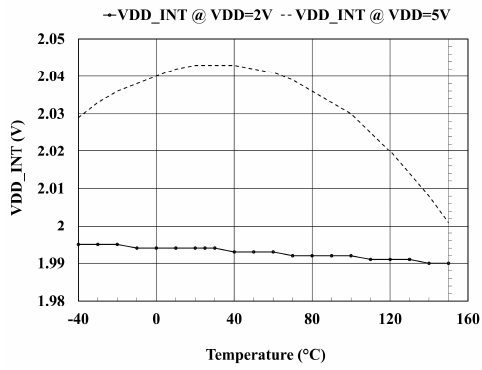
Figure 5. Constant internal supply voltage adjustment with temperature. The typical minimum and maximum V DD _ INT potentials reached for each simulated supply voltage were 1.99 V with 1.995 V for V DD = 2 V and 2.001 V with 2.043 V for V DD = 5 V . These numbers show that a 2 V voltage source compensated with V DD and temperature was achieved.